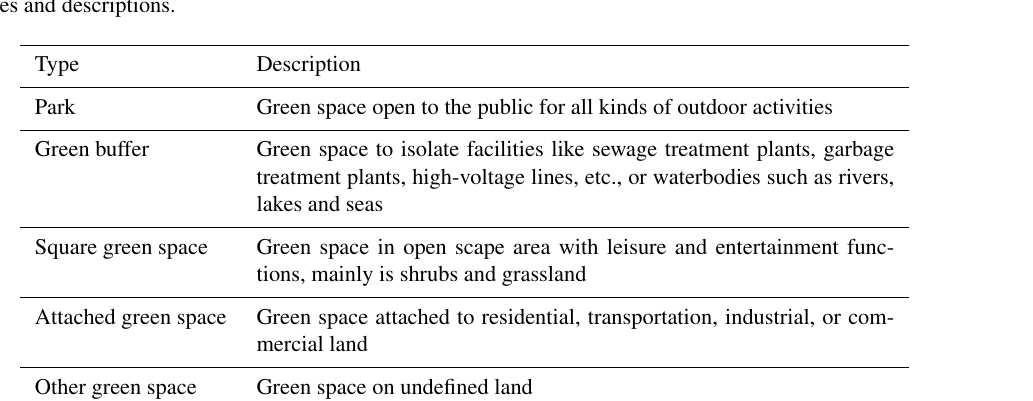
Figure 2. Distribution of 31 major cities in China. Table 1. UGS types and